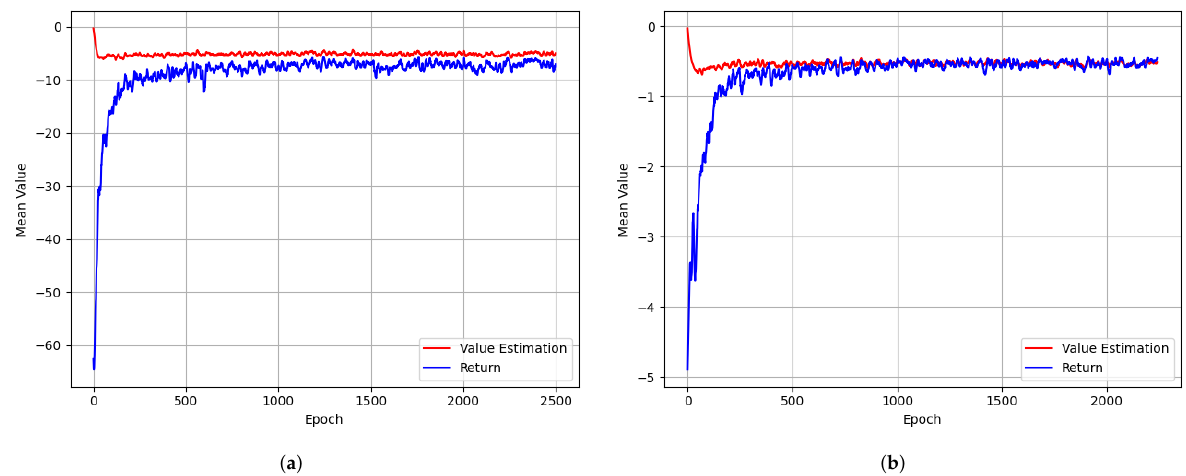
Figure 2. Demonstrating overestimation in the value estimation of TD3 with and without decayed hindsights on parking-v0 during the training process (for approximately 1 million steps). ( a ) TD3 without decayed hindsights; ( b ) TD3 with decayed